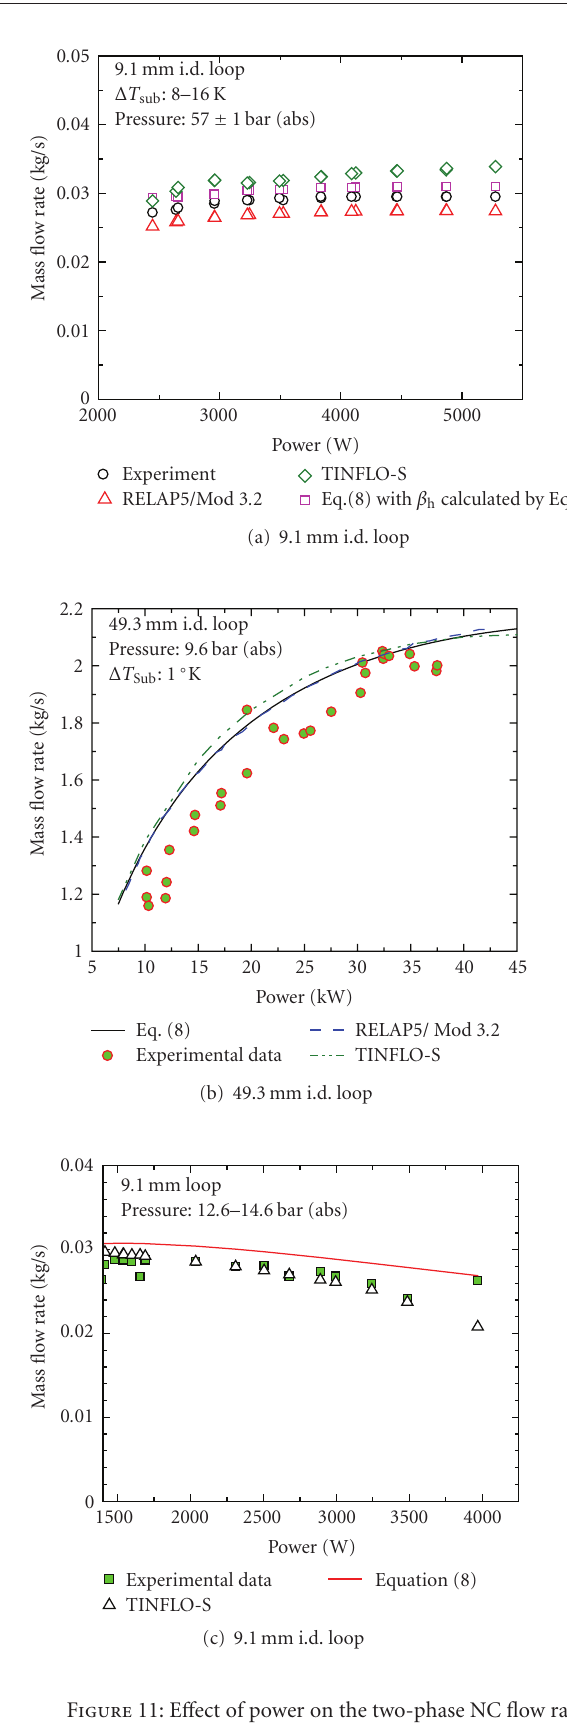
Figure 11: E ff ect of power on the two-phase NC flow